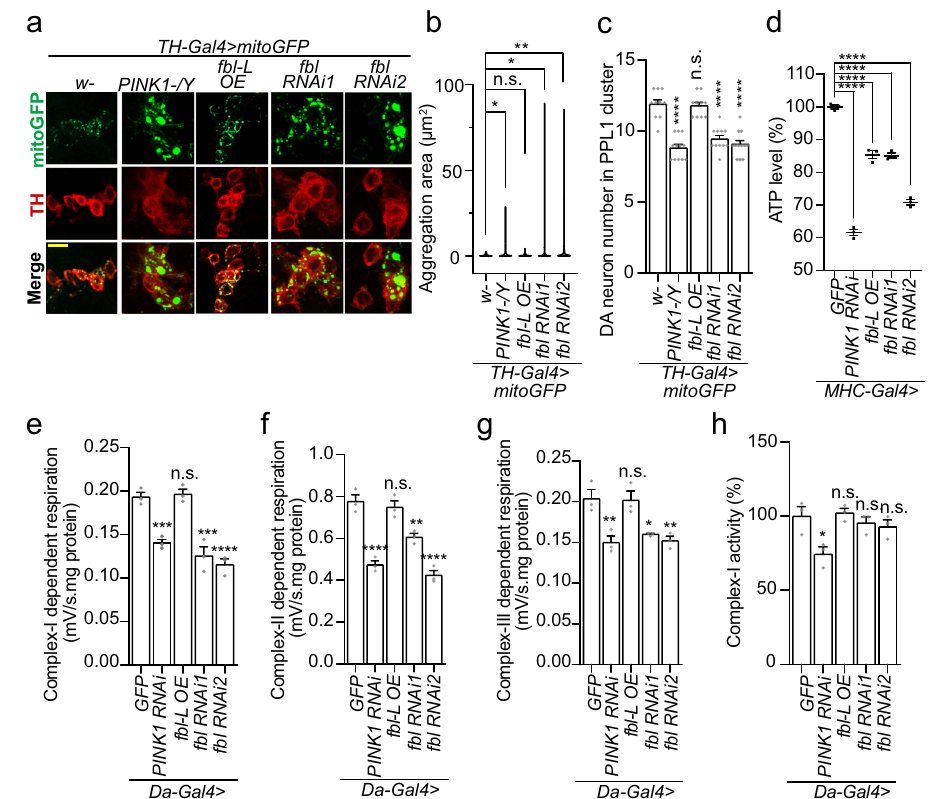
Fig. 1 Fbl Regulates Mitochondrial Functions in Drosophila . a Immunostaining showing effects of fbl on mitochondrial morphology in TH-positive dopaminergic (DA) neurons. WT ( w-/Y ) and PINK1 mutant ( PINK1-/Y ) serves as the negative and positive controls. Scale bar, 10 µ m. In this and all subsequent immunostaining fi gures of DA neurons, mitochondrial morphology is monitored by the mitoGFP reporter. b Violin plots showing the quanti fi cation of ( a ). In this and all subsequent mitochondrial quanti fi cations in neurons, the signi fi cance was calculated by using two-proportion Z test, and the threshold was set to 3 µ m 2 . n = 3 biologically independent samples. c Effects of fbl on DA neuron loss in fl y PPL 1 cluster. In this and all subsequent DA neurons counts. n = 10 ( w- , fbl-L OE) and 12 (other genotypes) biologically independent animals. d Effects of fbl on ATP level in fl y indirect fl ight muscle. n = 3 biologically independent samples. e – g Effects of fbl on complex-I, -II and -III dependent respirations. h Effects of fbl on complex-I activity. For assays in ( d – h ), n = 3 biologically independent samples. For all assays in ( b – h ), w- or UAS-GFP was used as control, and the signi fi cance was calculated by using one way ANOVA followed by post hoc Dunnett ’ s multiple comparation test. Data are presented as mean values ± SEM; n.s. not statistically signi fi cant; * p < 0.05; ** p < 0.01; *** p < 0.001; **** p < 0.0001. Source data are provided as a Source Data fi